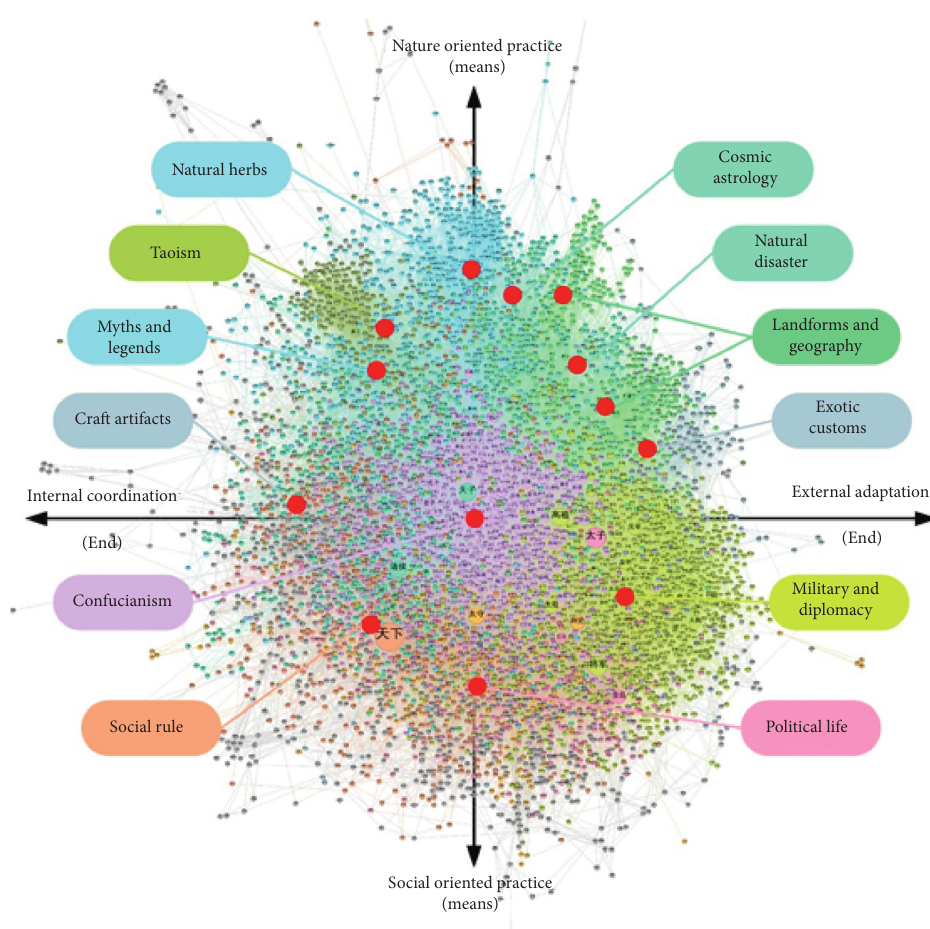
Figure 6: Communities and topics in the complex network of traditional Chinese cultural